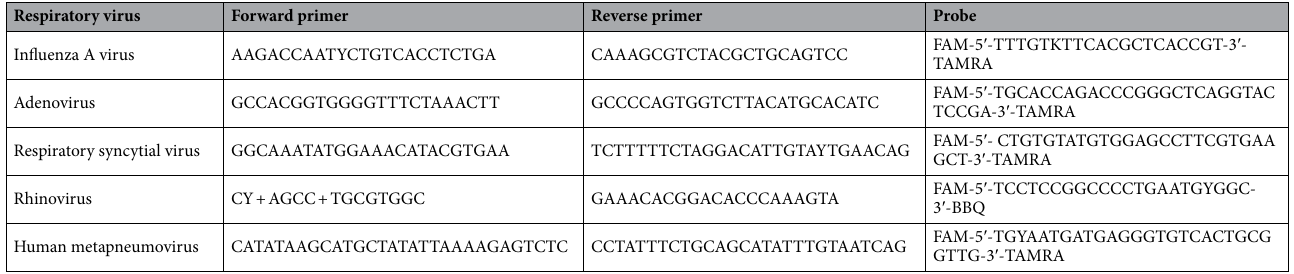
Table 1. RT-PCR primers and probes used in this